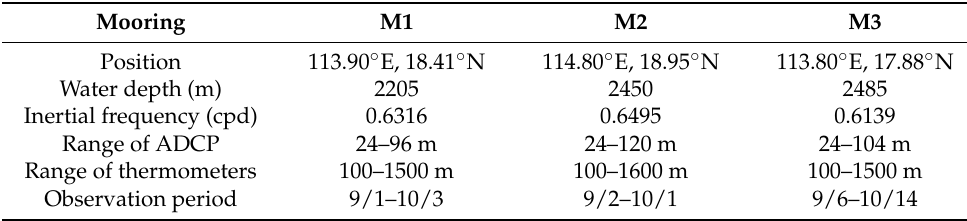
Figure 1. The track of the 2020 typhoon Noul with its six-hour positions denoted by asterisks (tropical depression) and squares (tropical storm). The locations of the three mooring stations are denoted by the red pentagrams, and the 2000 m isobath is denoted by the thin dashed lines. Table 1. Detailed information of the three